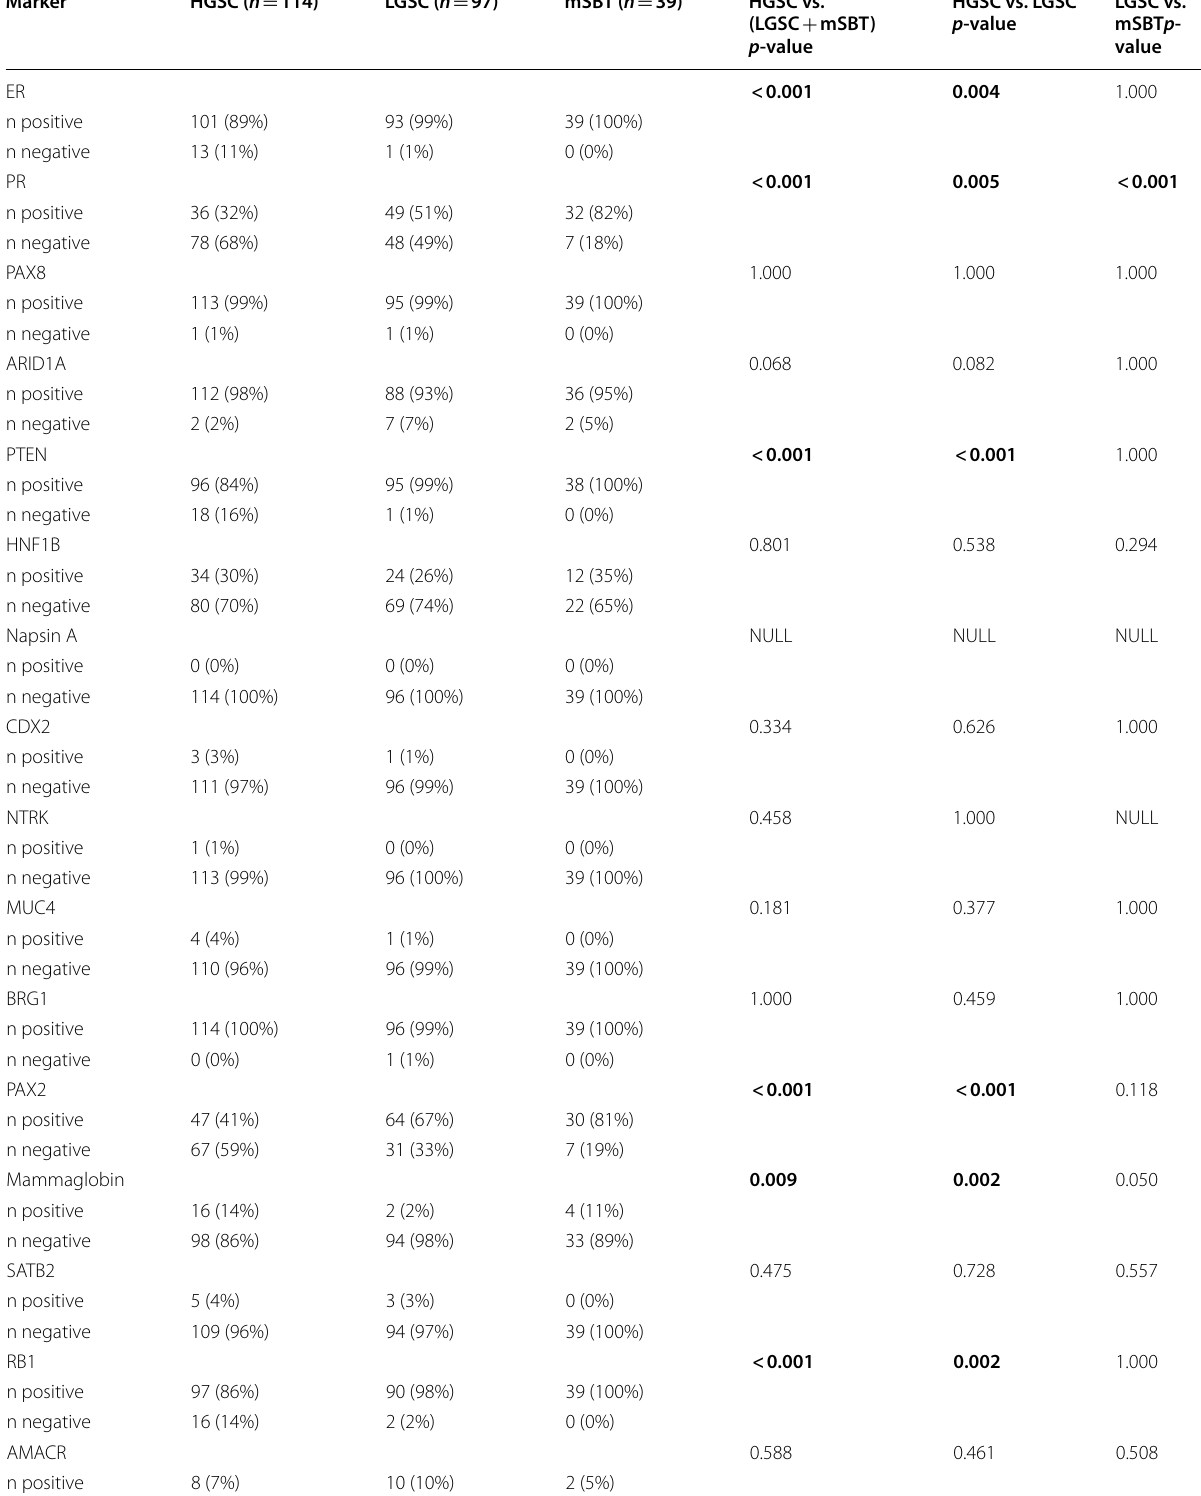
Table 3 Overview of the expression of 26 markers based on categorical scoring: positive ( positive tumor cells)